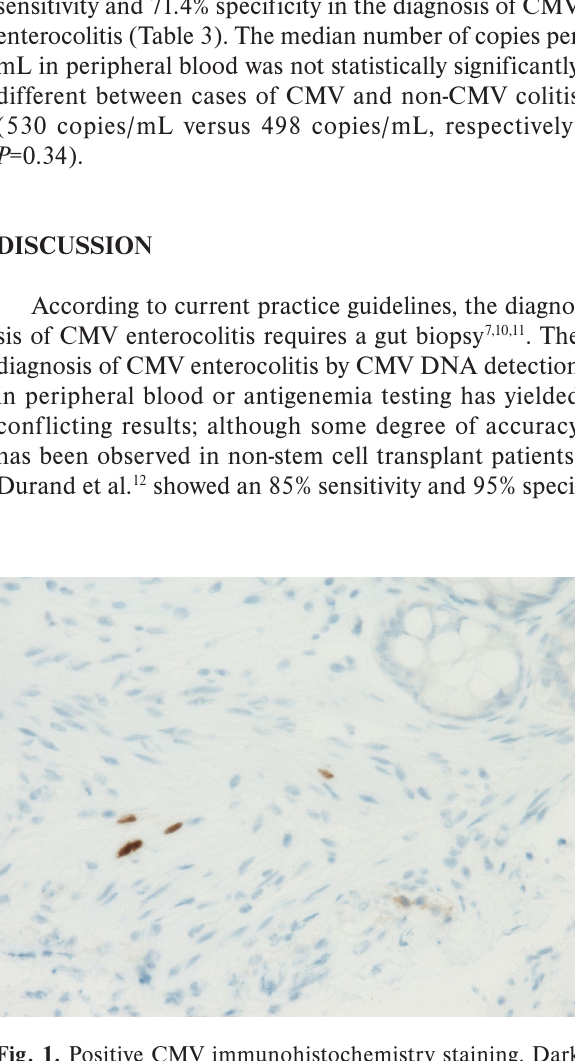
Fig. 2. Negative CMV immunohistochemistry